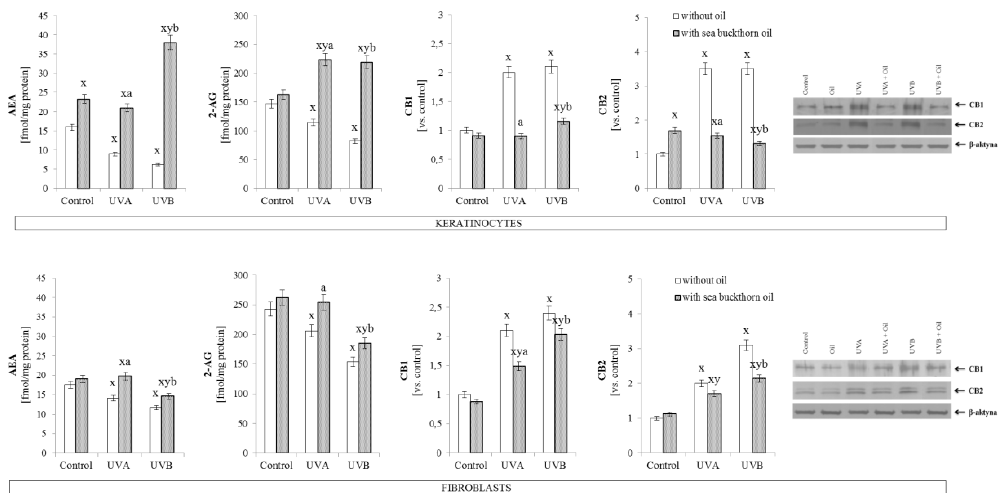
Figure 5. The level of endocannabinoids (AEA, 2-AG) and endocannabinoid receptors (CB1, CB2) in keratinocytes and fibroblasts after exposure to UVA (30 J/cm 2 and 20 J/cm 2 ) and UVB radiation (60 mJ/cm 2 and 200 mJ/cm 2 , respectively) and sea buckthorn seeds oil (500 ng/mL) treatment. Mean values ± SD of five independent experiments are presented. x statistically significant differences vs. control group, p < 0.05; y statistically significant differences between UVA/UVB and oil treated groups vs. oil treated control group, p < 0.05; a statistically significant differences between UVA and oil treated group vs. UVA treated group, p < 0.05; b statistically significant differences between UVB and oil treated group vs. UVB treated group, p < 0.05.